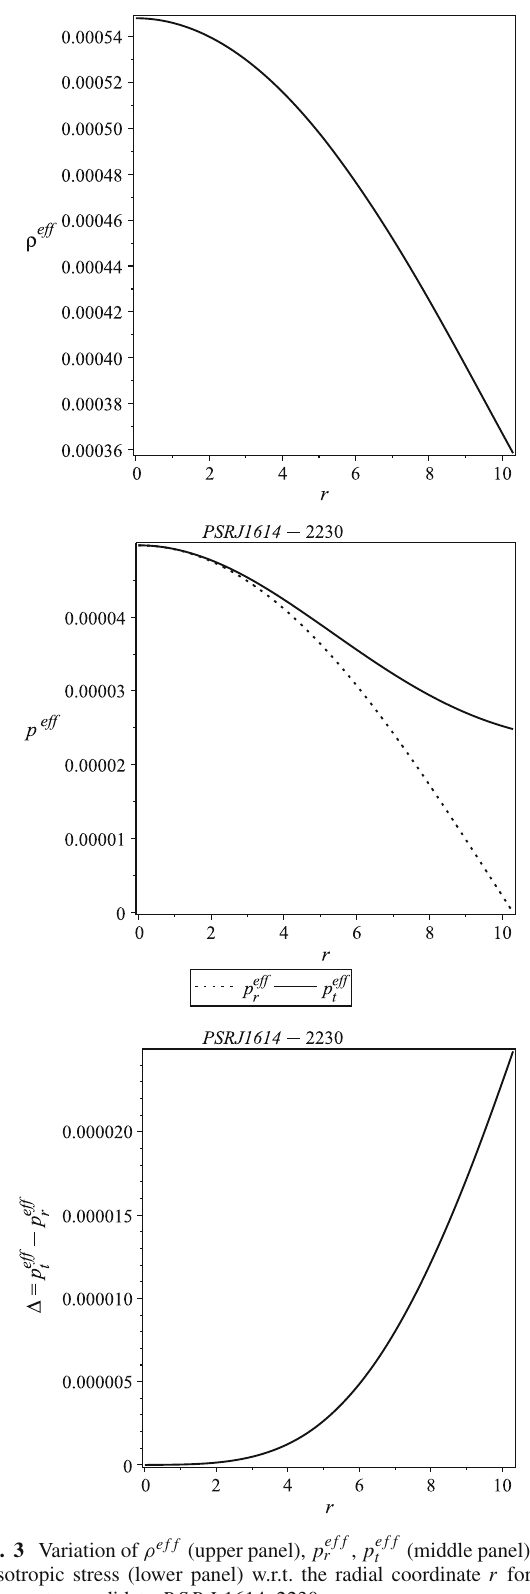
Fig. 3 Variation of ρ ef f (upper panel), p ef f r , p ef f t (middle panel) and anisotropic stress (lower panel) w.r.t. the radial coordinate r for the